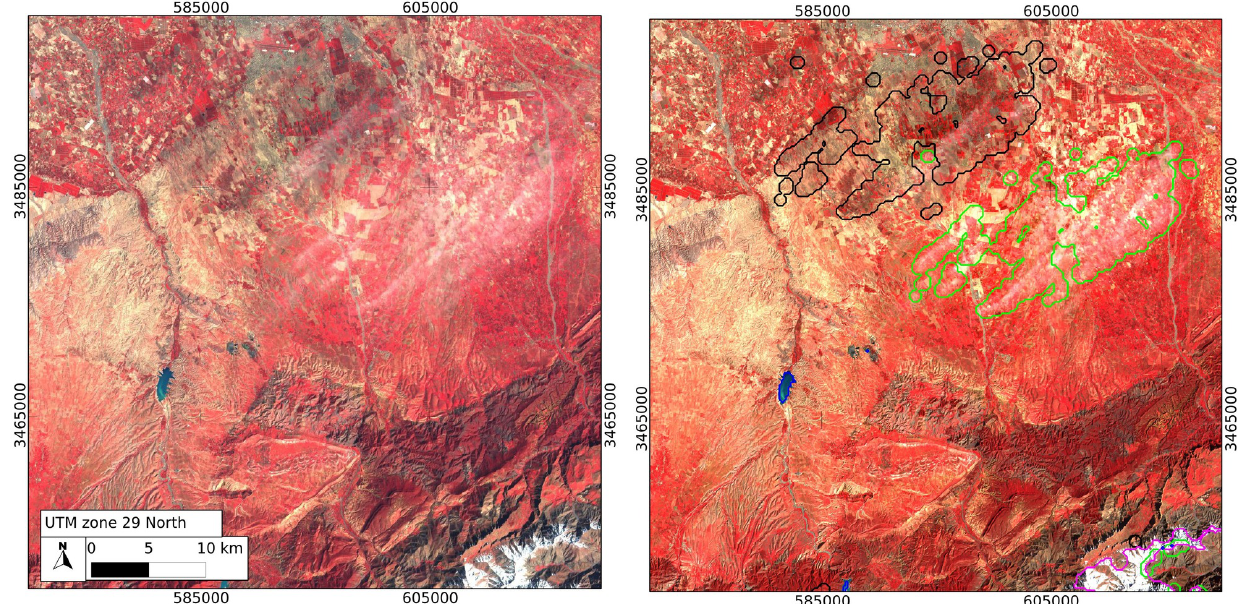
Figure 2. Example of a Level 1C product ( left ) and a Level 2A ( right ) product on the Morocco site on 7 March 2013. A (red, green, blue) composite is made with (NIR, red, green) SPOT-4 reflectances, with the same color scale factor in both products. On the Level 2A product, the clouds and shadows, water and snow are respectively circled in green and black, blue and